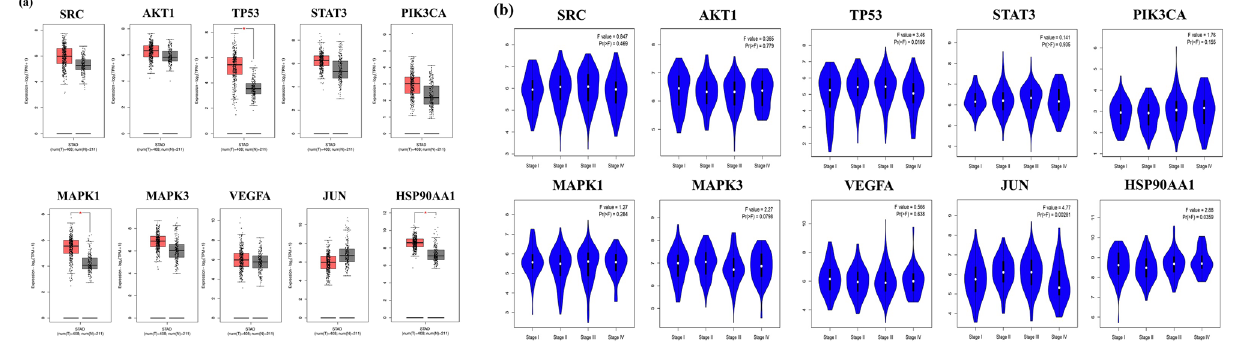
Figure 7. The mRNA expression levels of hub genes in The Cancer Genome Atlas (TCGA) and Genotype– Tissue Expression (GTEx) databases. ( a ) Boxplot of hub gene mRNA expression levels in the GEPIA database. Red represents GC tissue, and grey represents normal gastric tissue. ( b ) Stage plot of hub genes mRNA expression level and pathological stage in the GEPIA database.